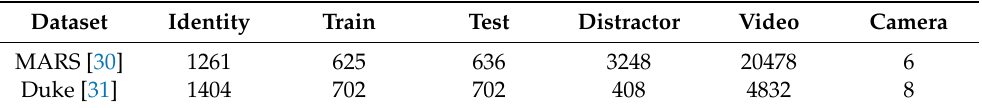
Table 2. Comparison of MARS and DukeMTMC-VideoReID, Duke = DukeMTMC-VideoReID dataset.